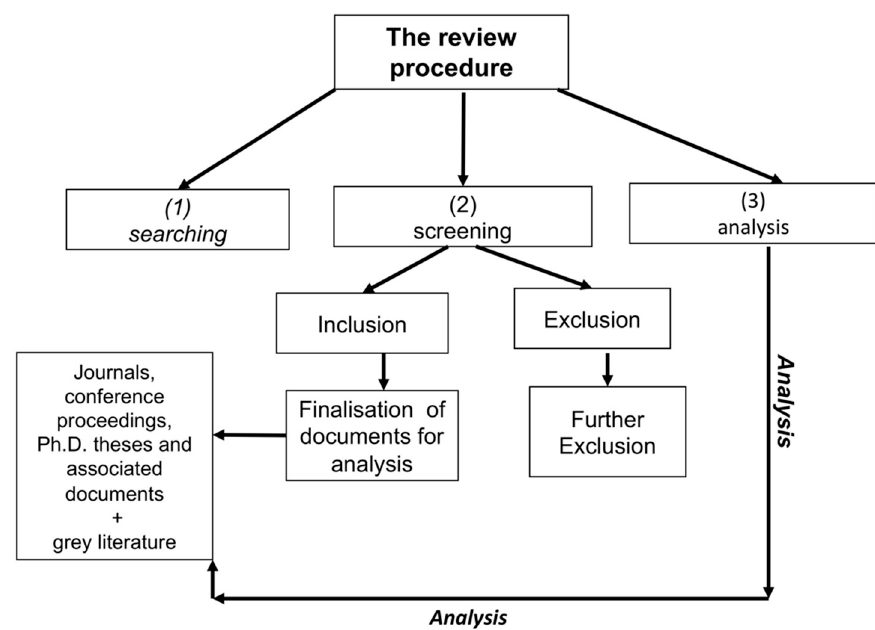
Figure 3. Methodological procedure.